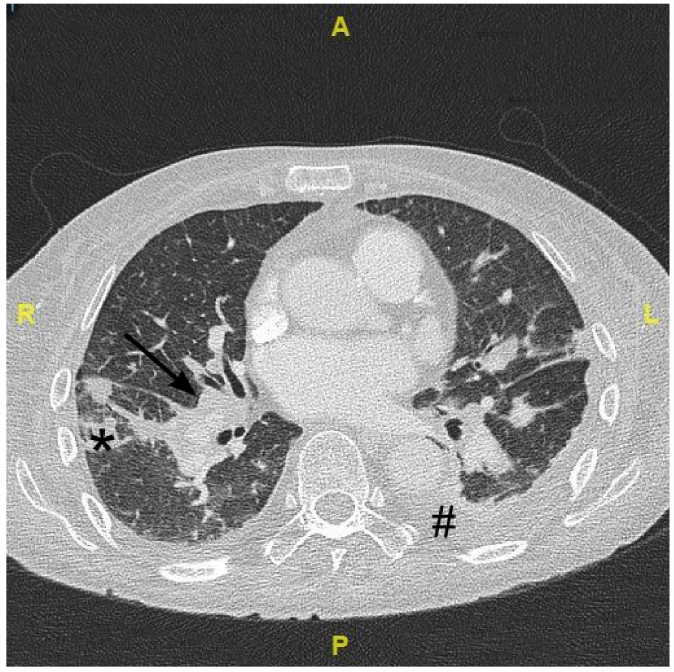
Figure 1. Cropped axial computed tomography image of the thorax on day 36 after admission showing mediastinal and bilateral hilar lymphadenopathy (arrow) as well as focal inflammatory consolidations within the lung parenchyma (star). Additionally, there are small pleural effusion (hash) and accompanying dystelectatic pulmonary areas. Abbreviations: A anterior; P posterior; R right; L